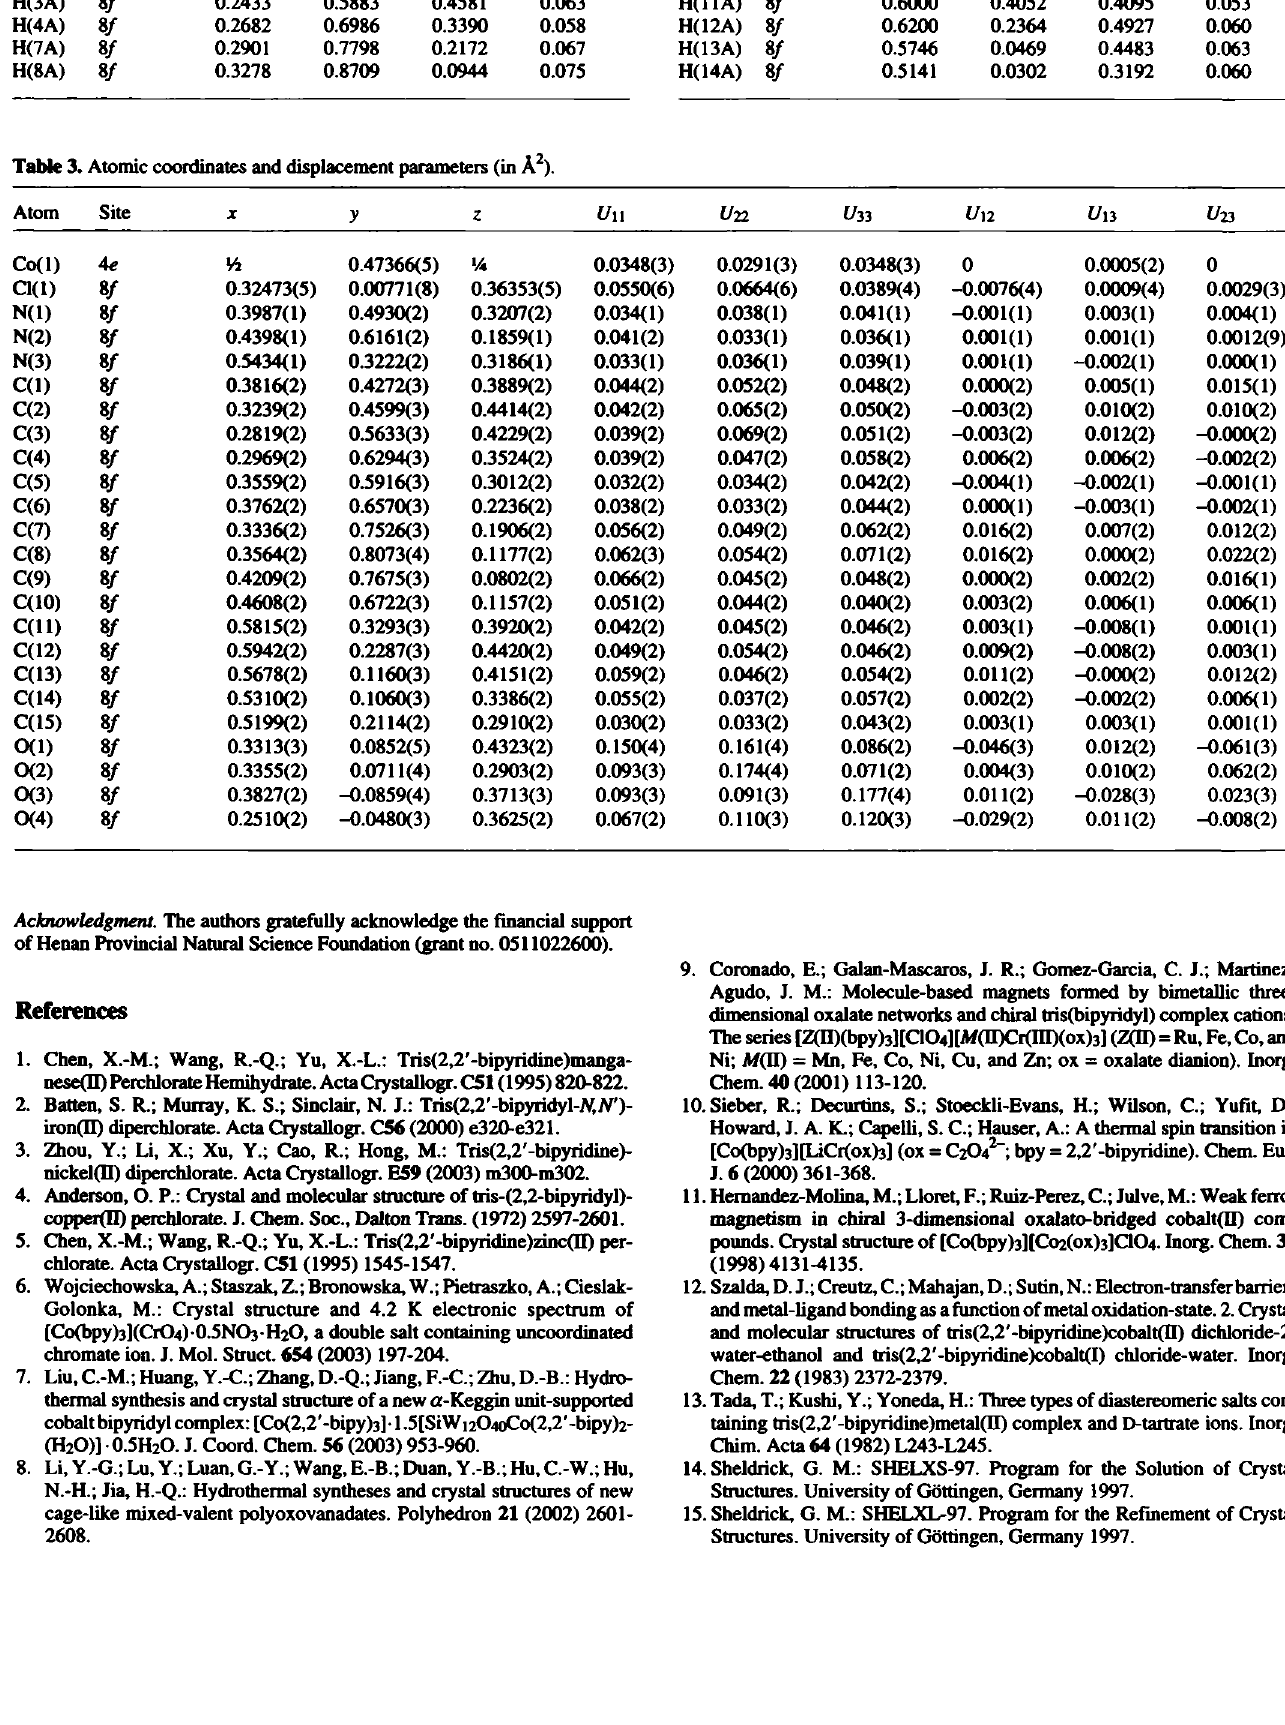
Table 3. Atomic coordinates and displacement parameters (in A 2